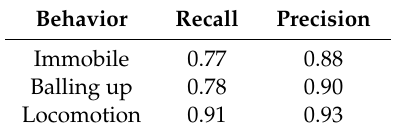
Table 2. Recall and precision [31] of the hedgehog model.